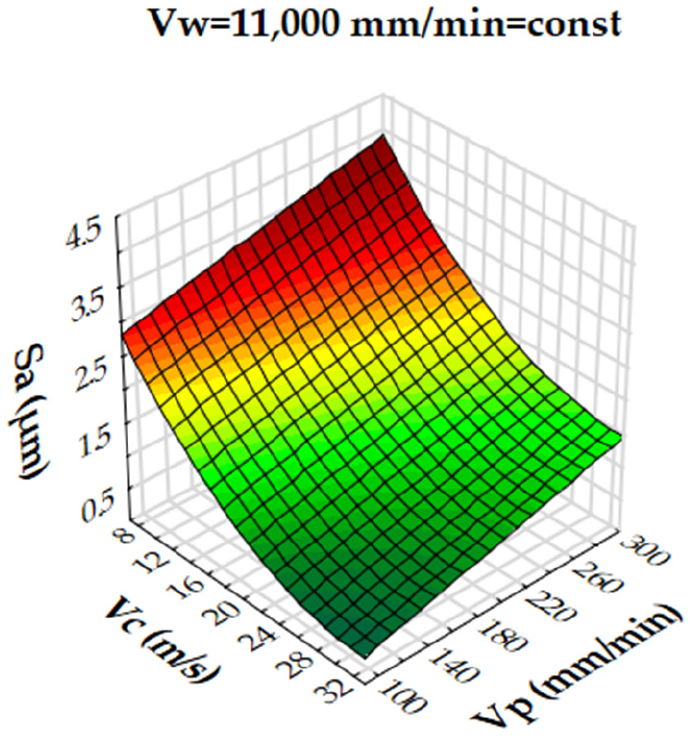
Figure 6. Dependence of the roughness, Sa, on the transverse feed rate, Vp, and the cutting speed, Vc, for a multigranular wheel (constant Vw).